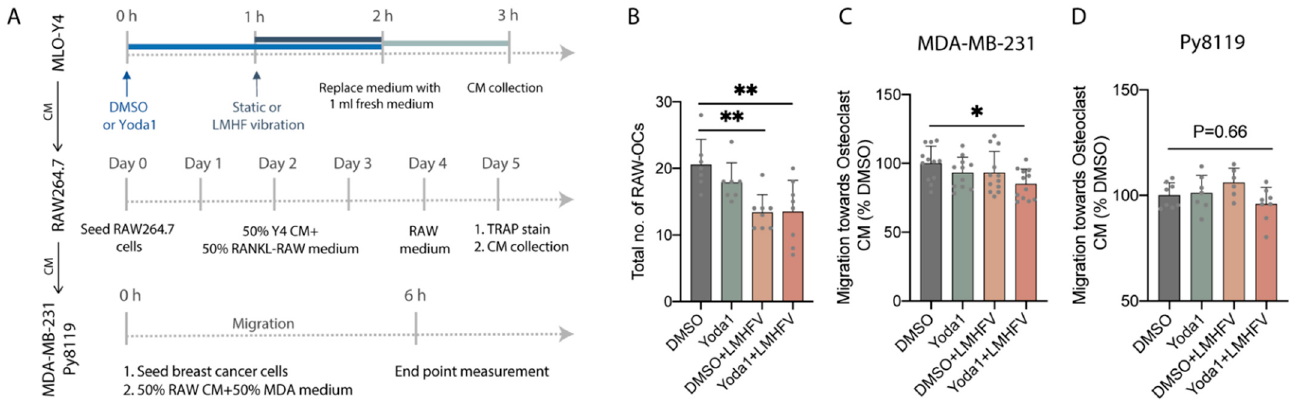
Figure 5. Combined treatment on osteocytes decreased osteoclastogenesis and further reduced the migration of breast cancer cells. ( A ) Experimental design of the CM study. ( B ) Total number of TRAP-positive RAW-OCs with more than 3 nuclei after 5-day differentiation under 50% CM from MLO-Y4 stimulated with DMSO, mono-treatments, or combined treatment and 50% growth medium supplemented with 20 ng/mL RANKL ( n = 7 − 8). ( C ) The migration of MDA-MB-231 cells through transwell toward RAW264.7 CM ( n = 11 − 12). Normalized to DMSO control. ( D ) The migration of Py8119 cells through transwell toward RAW264.7 CM ( n = 6 − 8). Normalized to DMSO control. * p < 0.05, ** p < 0.01.